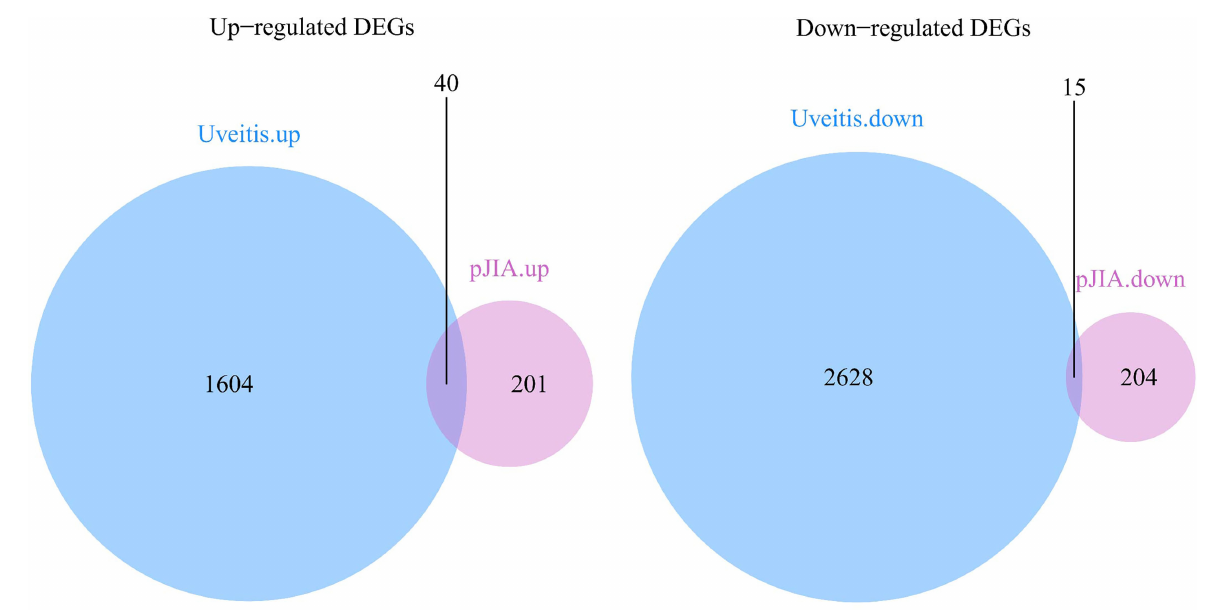
FIGURE 1 Differentially expressed genes in pJIA and uveitis. Up-regulated shared DEGs: MMP9, IGF2R, CYP4F3, SORL1, LRP10, PLCG2, WNK1, TPP1, ALOX5, FNBP1, ATP6V0A1, WAS, ARID1A, TGOLN2, UBA1, LBR, CAPN1, SYK, IL6R, RBM10, MED16, GAK, ACTN4, SNX27, COPA, CD99L2, APAF1, CBL, GLG1, DEF6, ANKRD11, PRKCSH, SMARCC2, KIDINS220, N4BP1, CNOT1, STK38, FDFT1, WDR37 SON. Down-regulated shared DEGs: RPAIN, DYNLRB1, MRPS18C, TMEM134, SEC61B, CCT2, FAM76B, MGST3, HNRNPC, RABEP1, BOLA2, TTC38, CREBRF, NDUFB7,